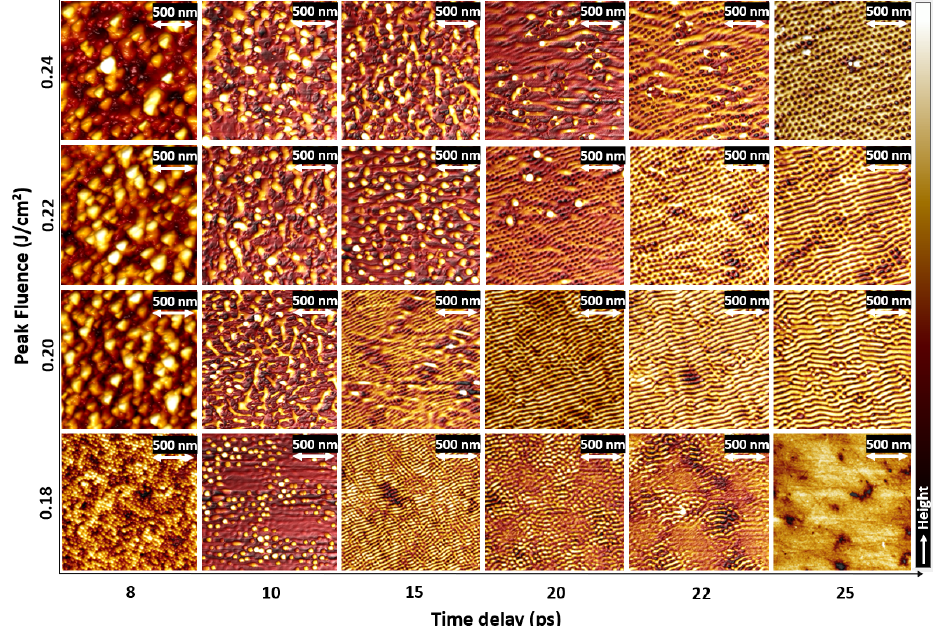
Figure 1. 2D AFM images of laser-induced nanopatterns formation on Ni(100) as a function of time de- lay and peak fluence at a fixed N DPS of 25. The different zones of interest are nanopeaks, nanobumps, nanohumps and nanocavities. They are created progressively at different doses: (0.18 J/cm 2 ; 8 ps), (0.18 J/cm 2 ; 10 ps), (0.18 J/cm 2 ; 15 ps), (0.24 J/cm 2 ; 25